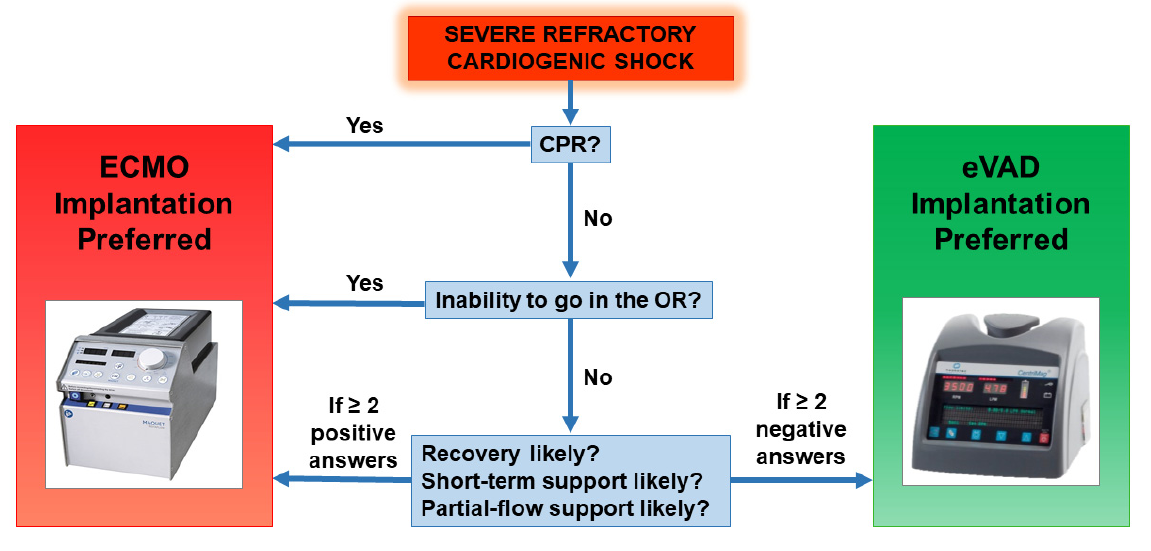
Figure 2. Decision-making flow chart for ECLS instauration and subsequent